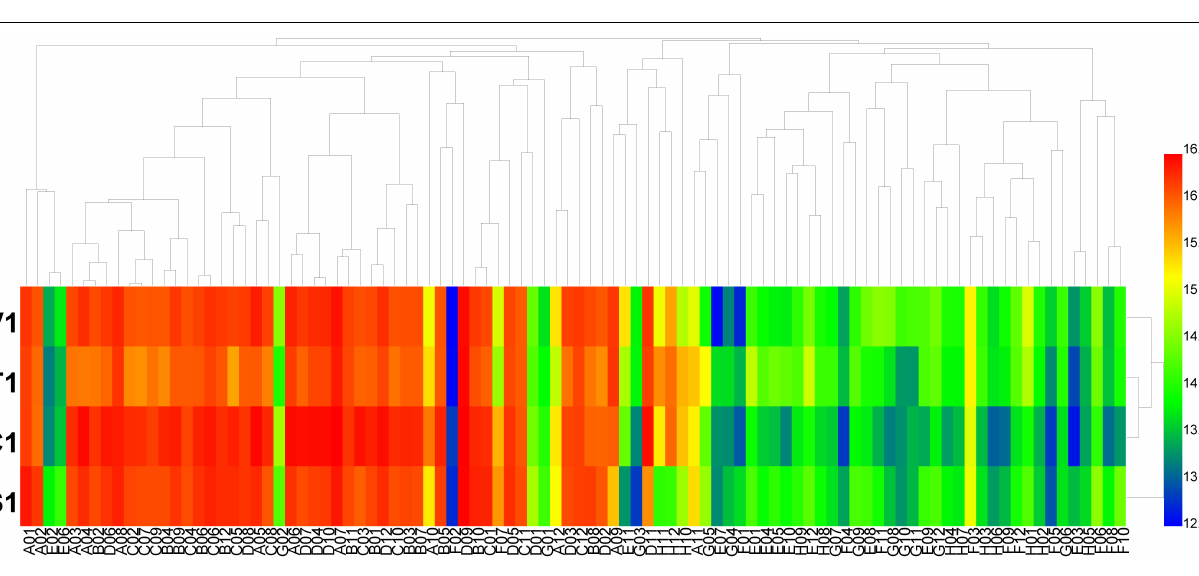
FIGURE 5 | Overview of metabolic phenotypes of four isolates of B. cinerea at 96 pH environments tested. V1, T1, C1, and S1 were the isolates of B. cinerea from tomato, tobacco, cucumber, and strawberry, respectively. Heatmap of maximum area values of pH environments expressed as maximum curve area monitored during 96 h of incubation. The legend of color code from blue to green, and red shades indicate low, moderate, and high metabolisation at pH environments, respectively, assessed as arbitrary Omnilog